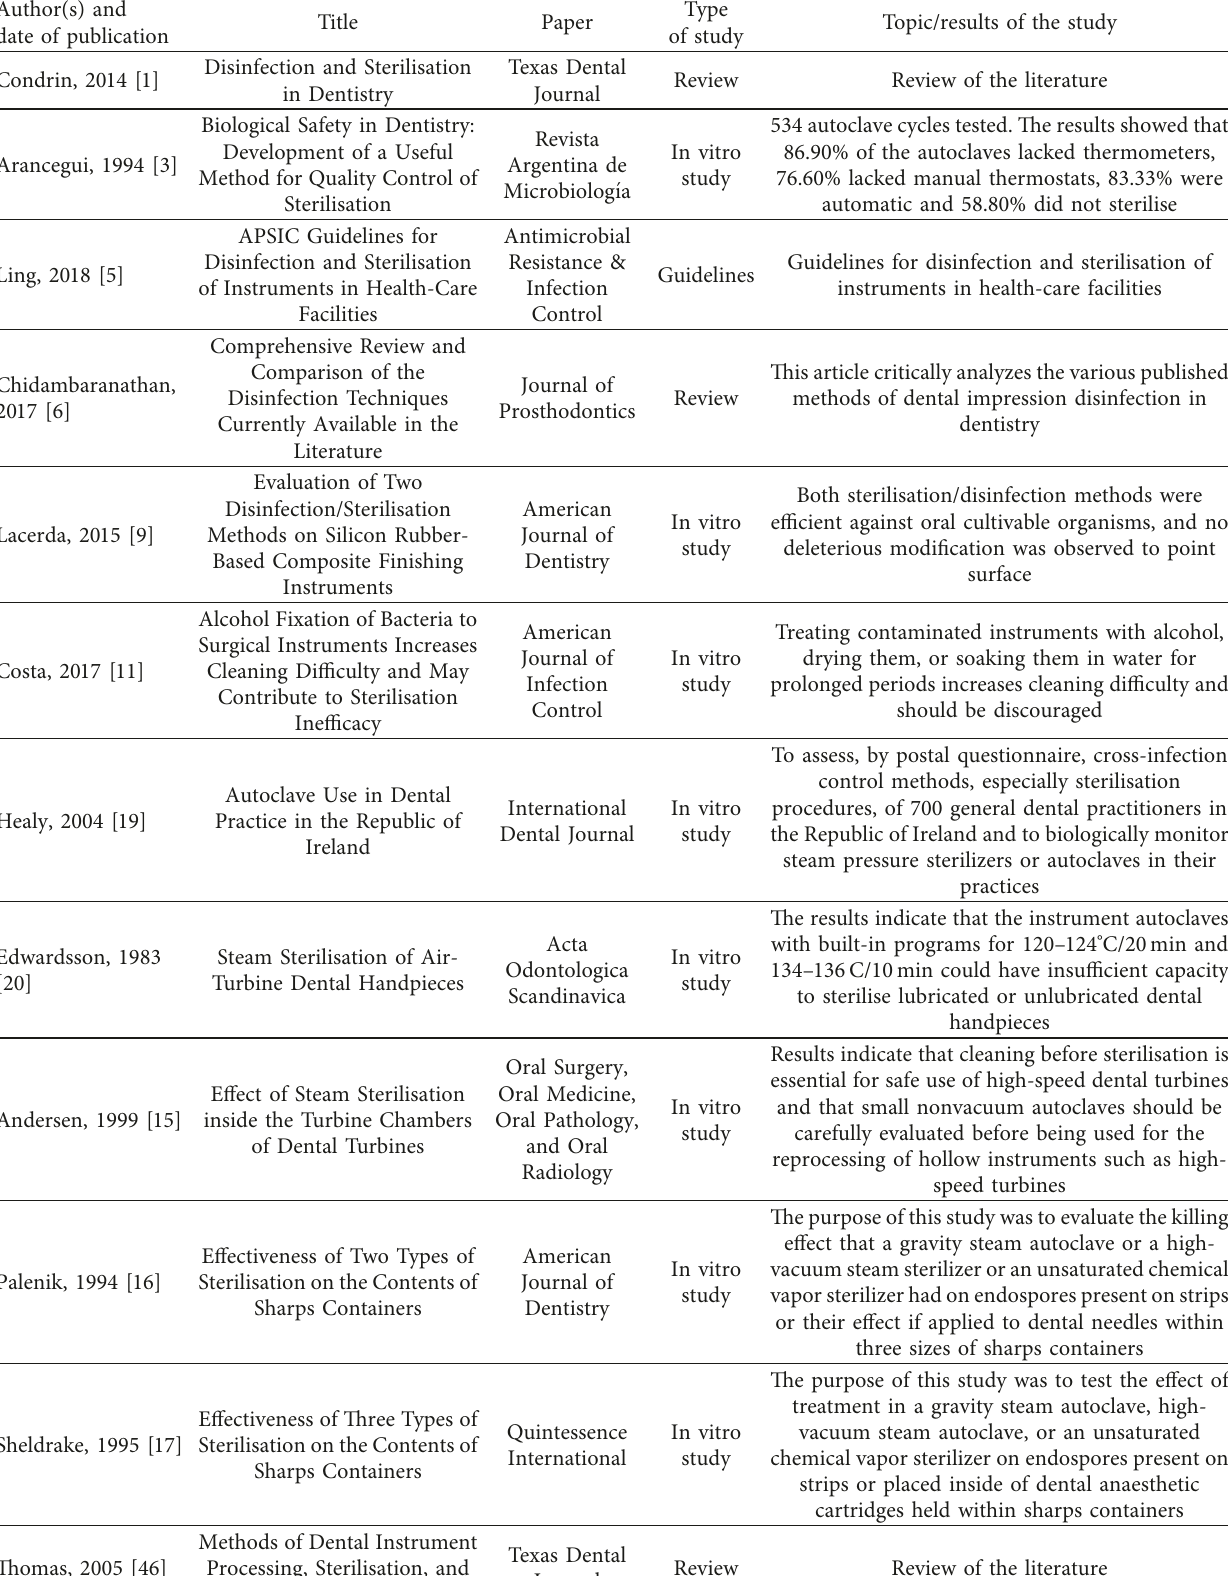
Table 2: The complete list of the 15 articles eligible for the qualitative analysis, with an appropriate description of their topics and their